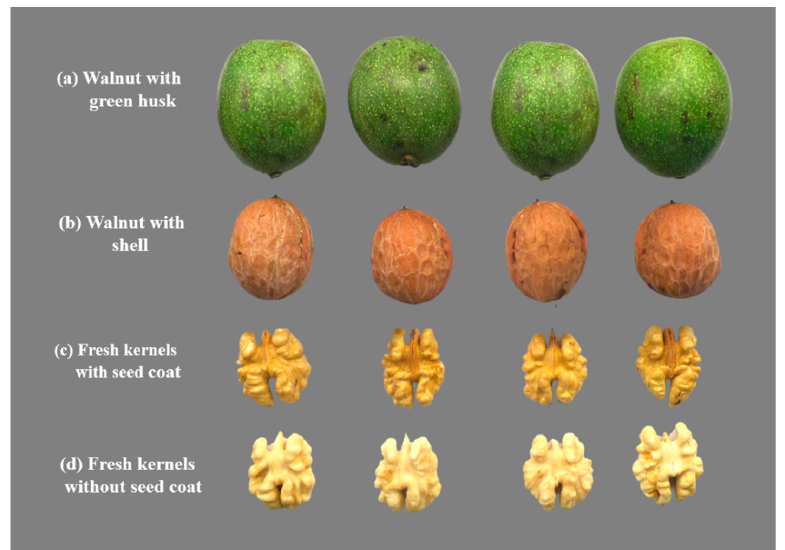
Figure 1. Different forms of fresh walnuts after harvesting: ( a ) walnut with green husk; ( b ) fresh walnut with shell; ( c ) fresh kernels with seed coat; ( d ) fresh kernels without seed